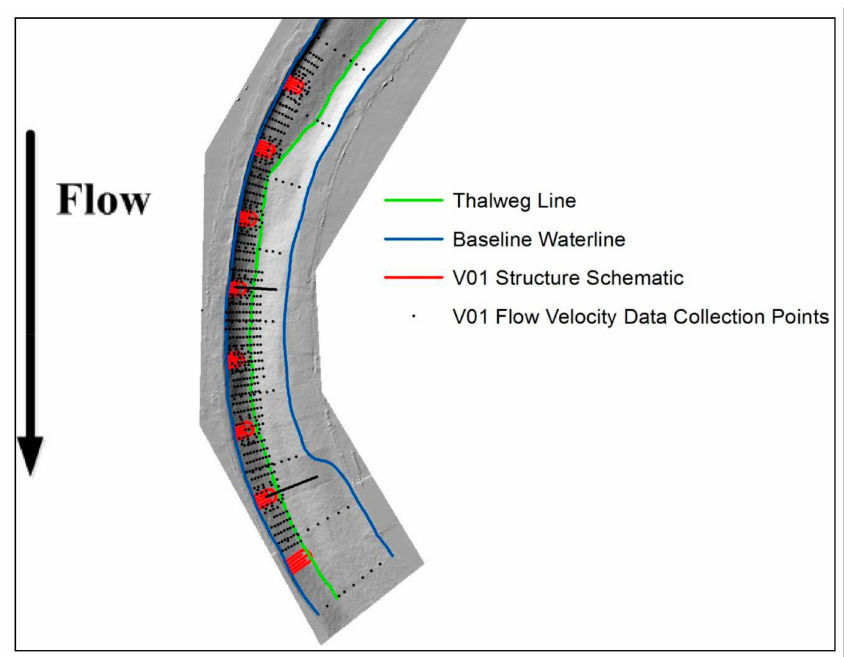
Figure 9. Rock vane configuration V01 and location of velocity measurements